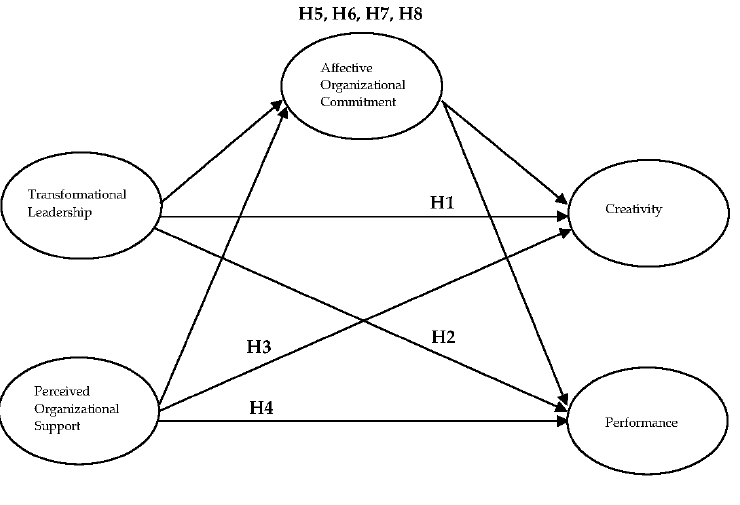
Figure 1. Proposed Figure 1. Proposed model.